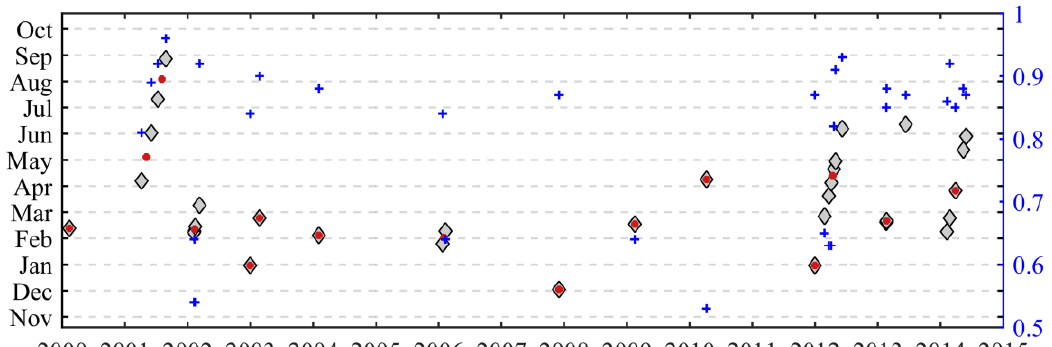
Figure 4. Fraction of year of the acquisition dates (displayed as month, left axis) for each DEM (gray diamonds), and grouped by every half calendar year using median values (red dots). Note that in our procedure this grouping is actually done pixel-wise and only average values are indicated as red dots. The right axis (blue) indicates the average fraction of snow cover (between 0.5, 50%, to 1, 100%) for the two glaciers and each acquisition date (blue crosses). Years on the horizontal axis refer to 1 January of each